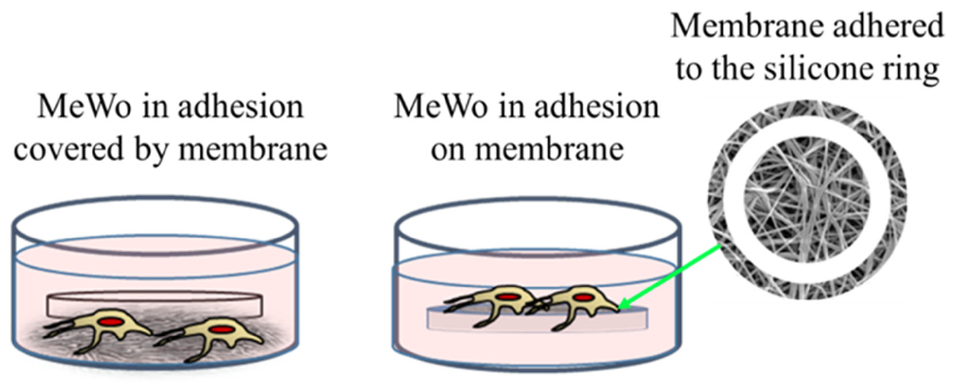
Figure 6. Cells’ culture and membrane: options tested.